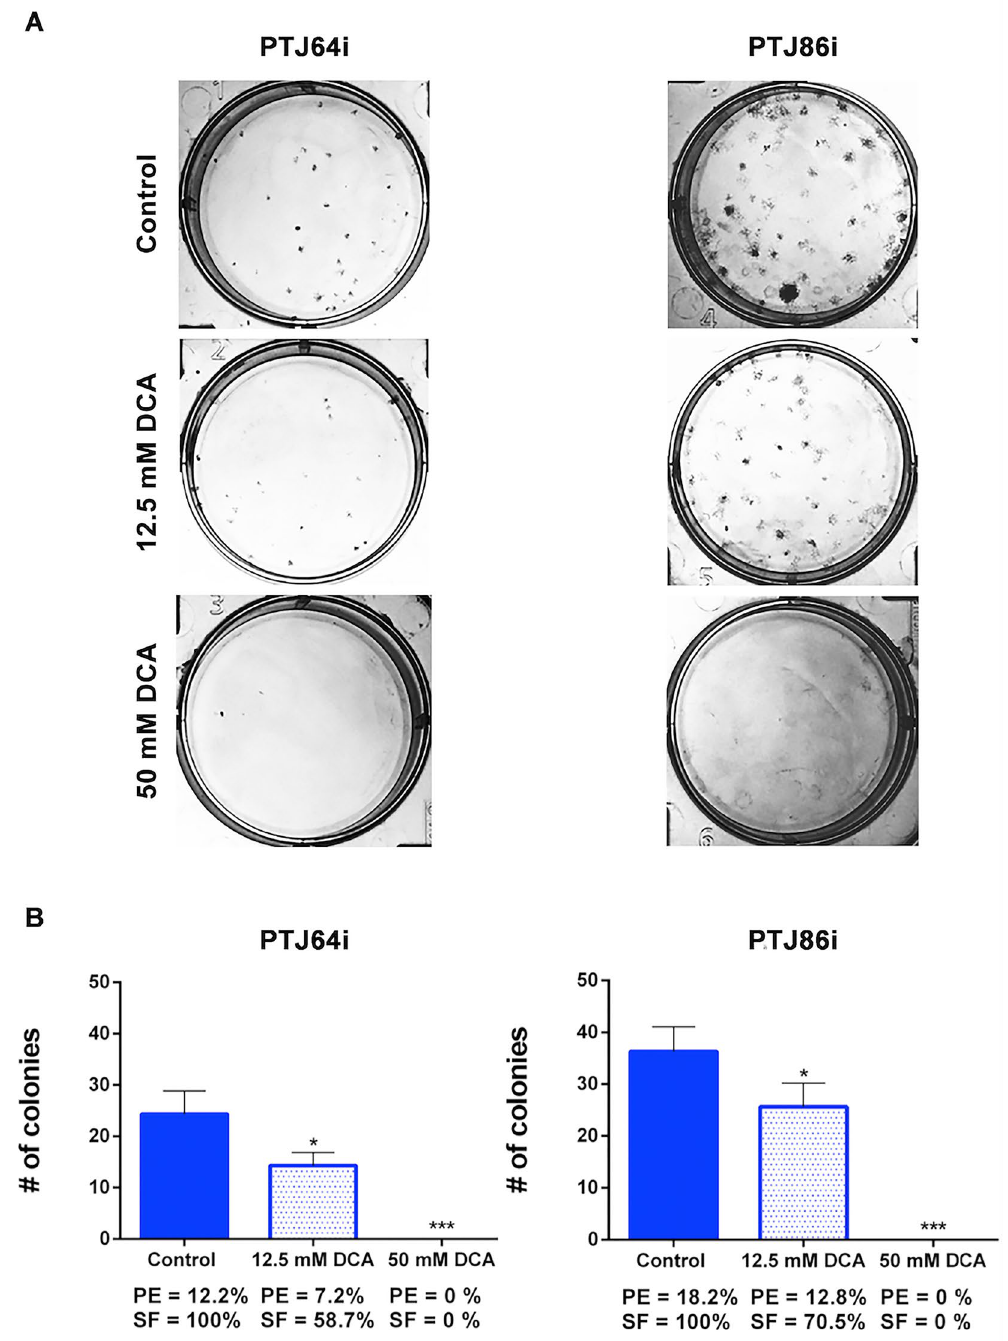
Figure 5. DCA affects clonogenic activity of PTJ64i and PTJ86i cell lines. (A) Representative plates of colony formation assays for both PGL cell lines are shown; (B) Histograms show the means ± SD of three independent experiments ( * p < 0.05; *** p < 0.001). PE: plating efficiency [(# of colonies formed/# of cells plated) * 100]; SF: surviving fraction [# of colonies formed * 100/(# of cells plated * PE of control